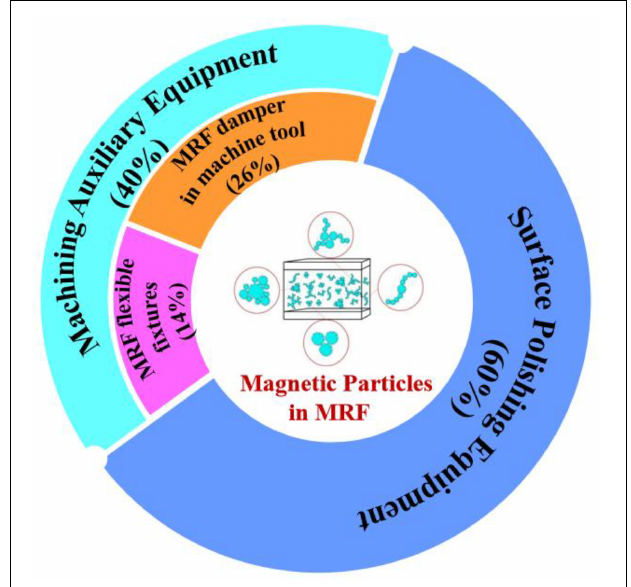
FIGURE 1 | Classification of MRF in modern precision machining according to the referred